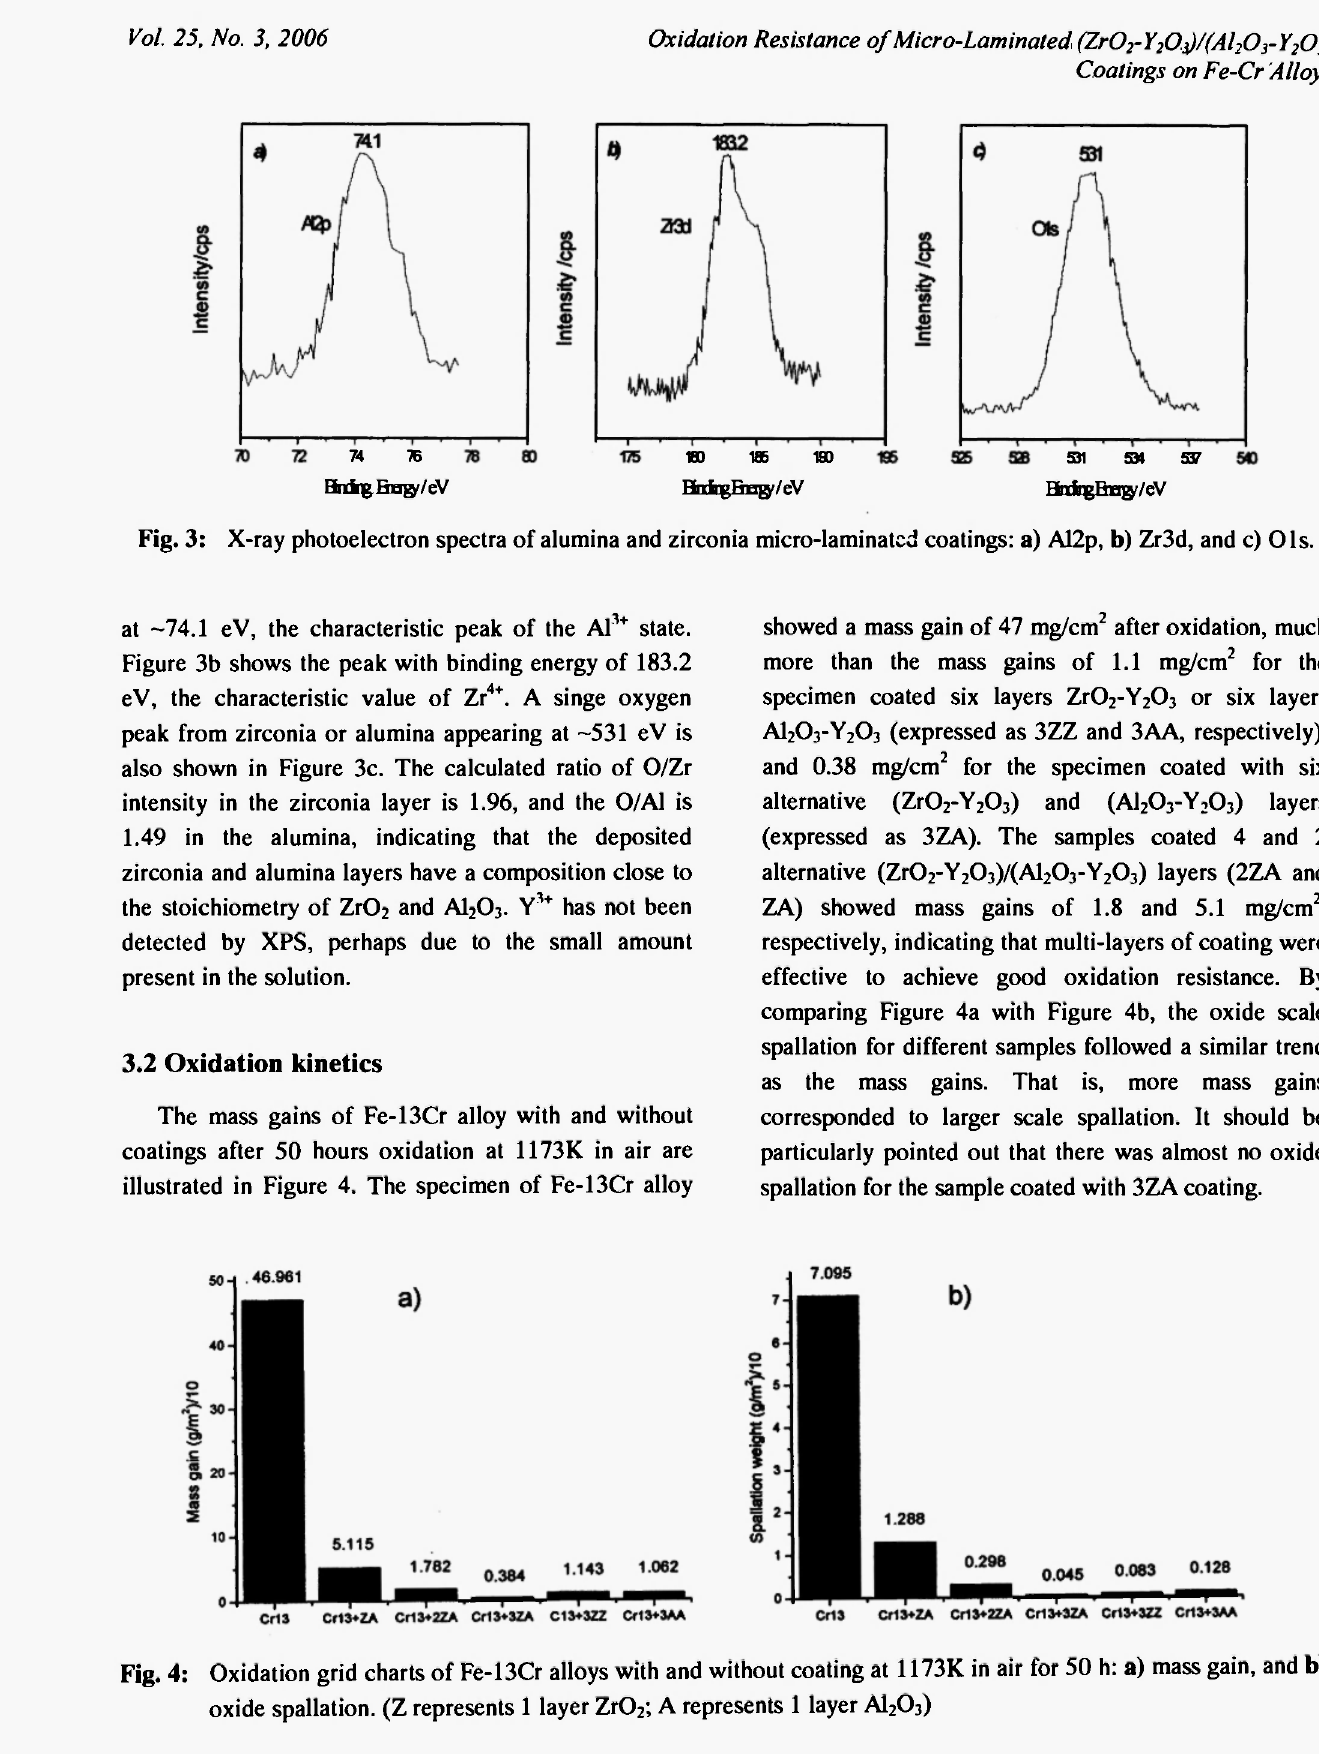
; A represents 1 layer A1 0 2 2 3